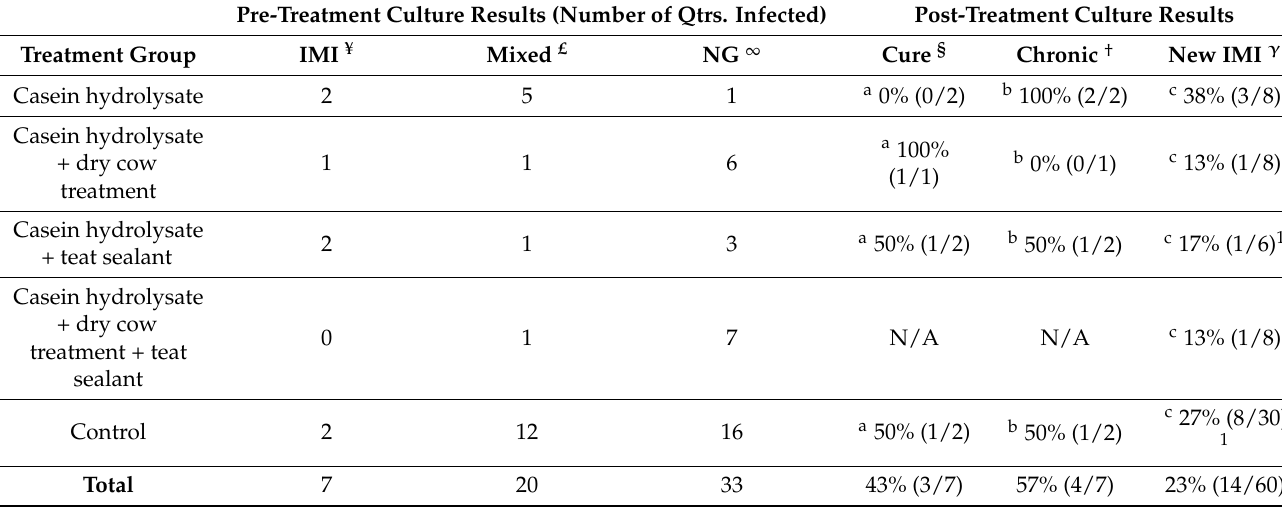
Table 2); † Strep spp. = non-agalactiae streptococci; γ New IMI = Any organism isolated from the first post-calving culture that was not present in either pre-treatment sample. These are the 14 new IMI shown in Table 2. Table 2. Bacteriological cures and chronic cases of intramammary infections during the dry period by treatment group. Pre-Treatment Culture Results (Number of Qtrs.